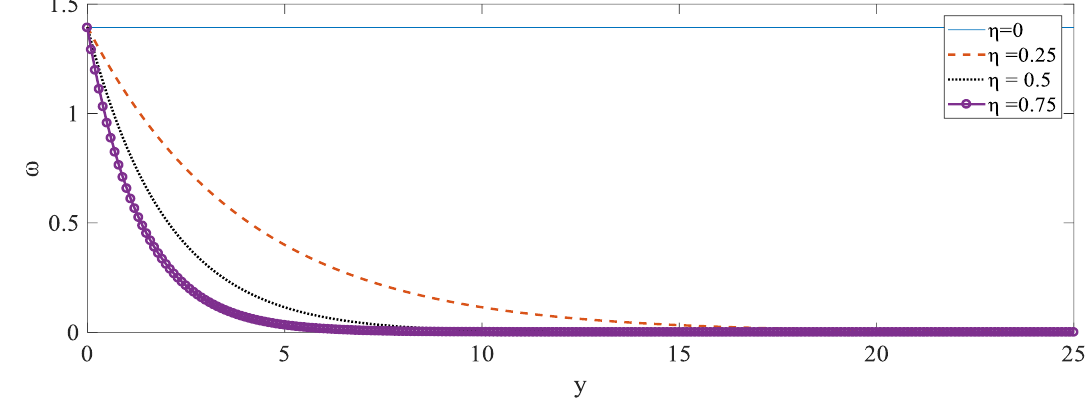
Figure 4. Angular velocity profile against displacement variable y for Nr=0.1, Pr=5, b=0.5, M=2, Sc=2, Kr=0.5, Du=0.5, Q=0.2, Q 1 =0.3, e=0.001, n=0.1, Kp=0.3, Gr=5, n 1 =0.2, h=0.4, Gm=0.3 at